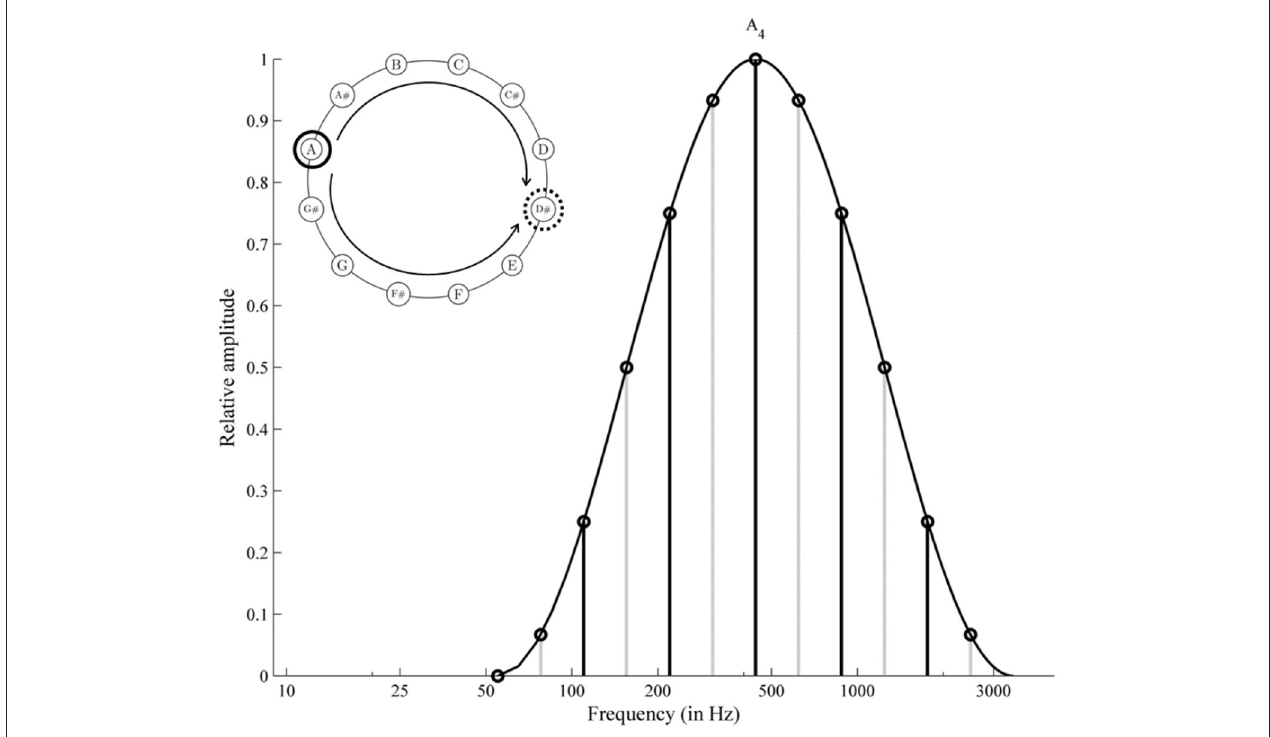
FIGURE 1 | Frequency spectrum of two Shepard tones forming a tritone. The clockwise distance equals the counter-clockwise distance on the pitch-class circle; the octave-spaced frequency components generated under the cosine envelope centered at A 4